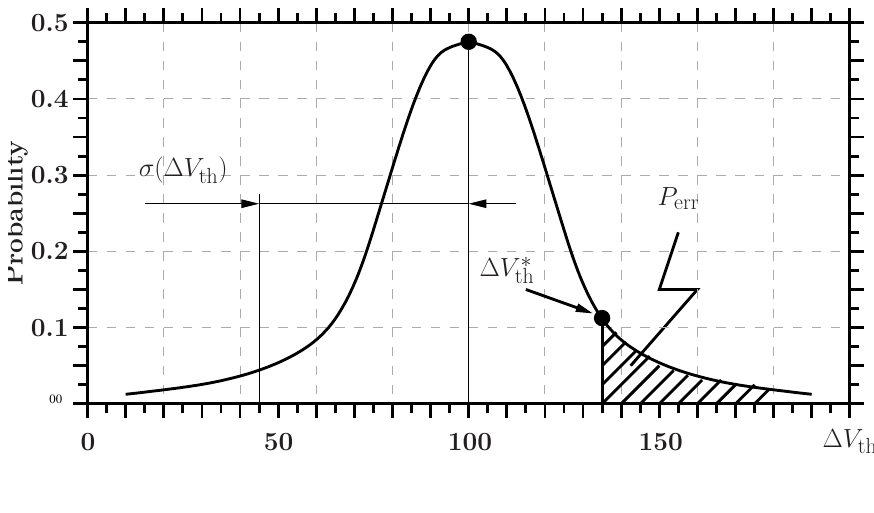
Figure 4. Probabilistic density function of ∆ V beyond which the transistor stops switching correctly. The shaded area represents the total error probability that the transistor